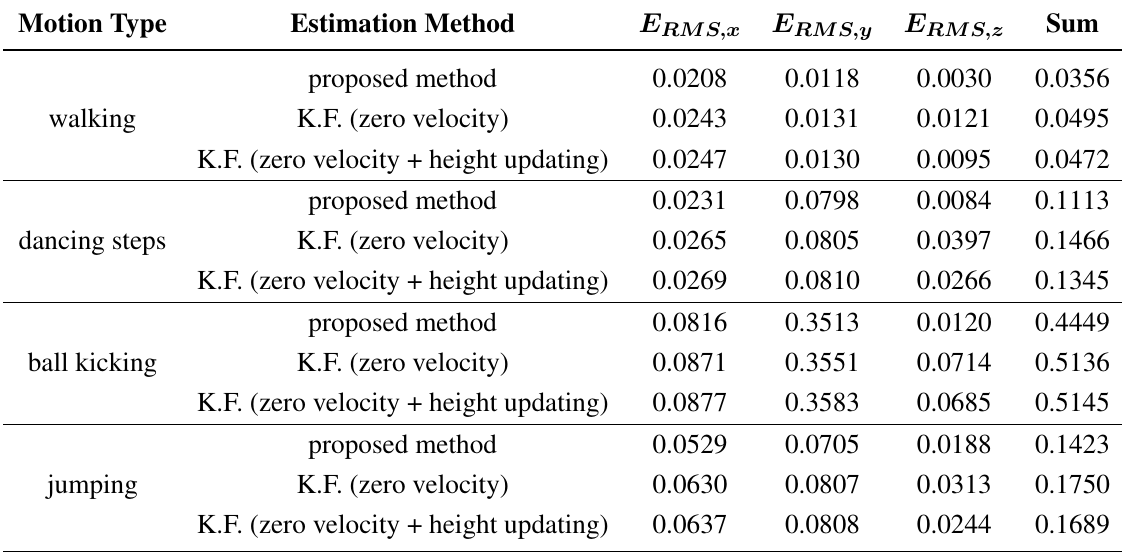
Table 2. RMS position error comparison of different methods (unit: